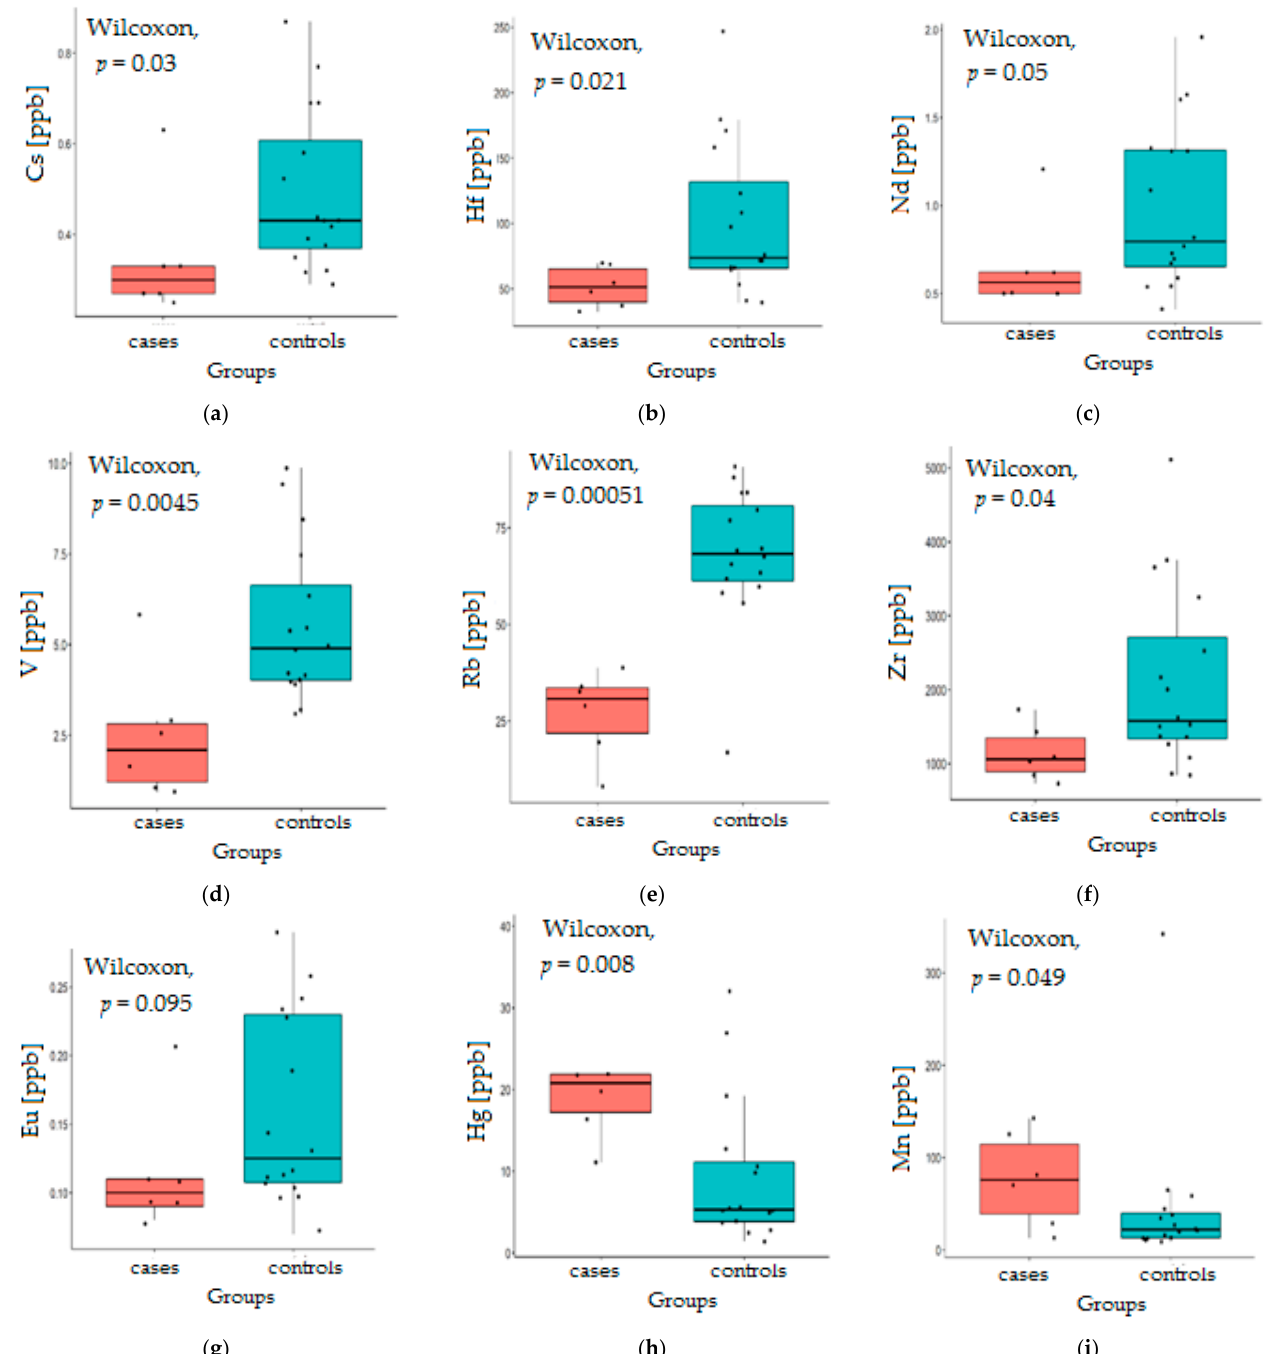
Figure 2. Statistical significance of the differences of the metallic contents in AH of HD patients (cases) compared to the controls for Cs (ppb) ( a ), Hf (ppb) ( b ), Nd (ppb) ( c ), V (ppb) ( d ), Rb (ppb) ( e ), Zr (ppb) ( f ), Eu (ppb) ( g ), Hg (ppb) ( h ), Mn (ppb) ( i ).